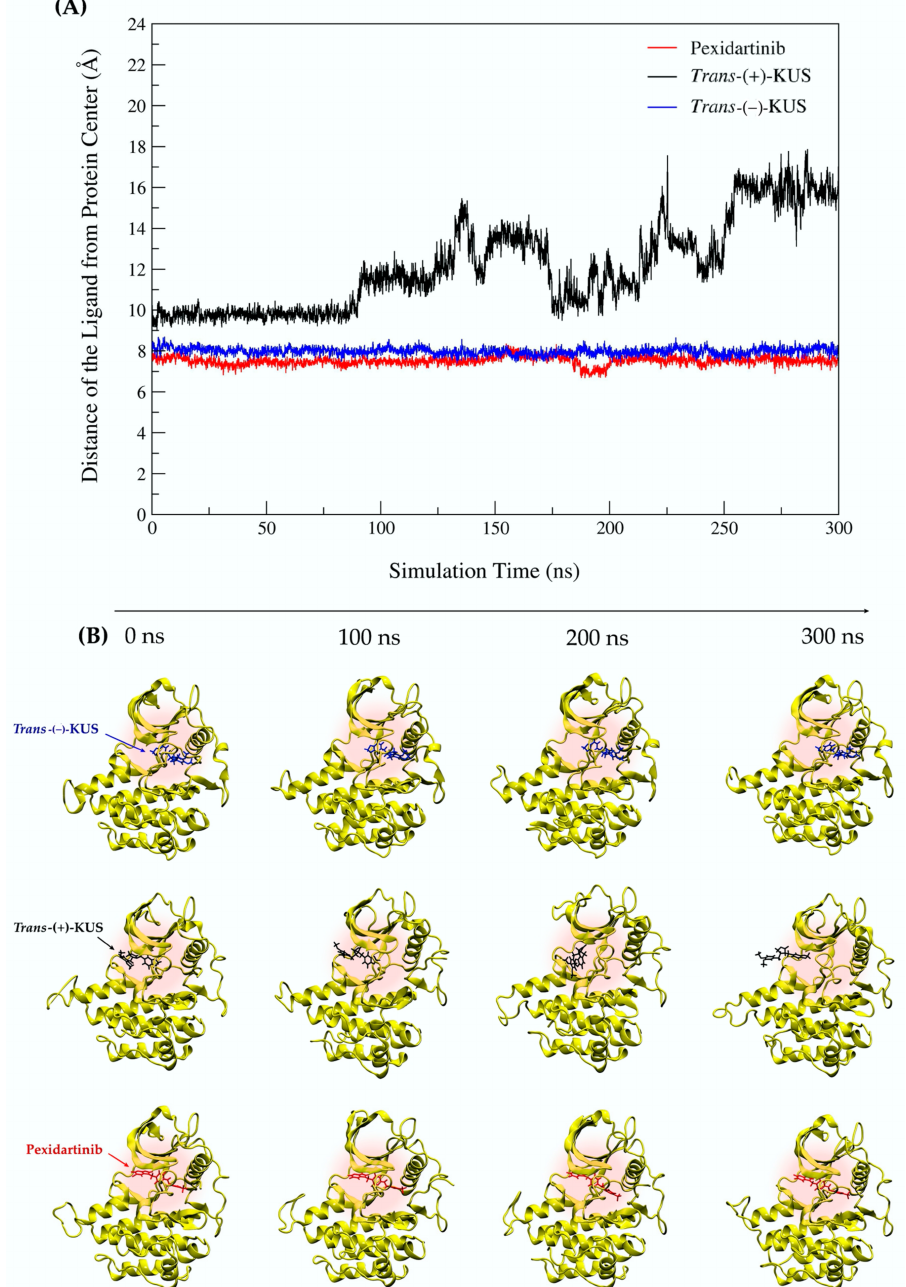
Figure 9. Ligand binding overtime: ( A ) distance of the ligands from protein center; ( B ) the position of ligand in the ligand-protein complex at the starting point (0 ns), 100 ns, 200 ns and 300 ns. The CSF1R structure was represented in yellow. The trans -( )-kusunokinin, trans -(+)-kusunokinin − and pexidartinib were represented in blue, black and red, respectively.